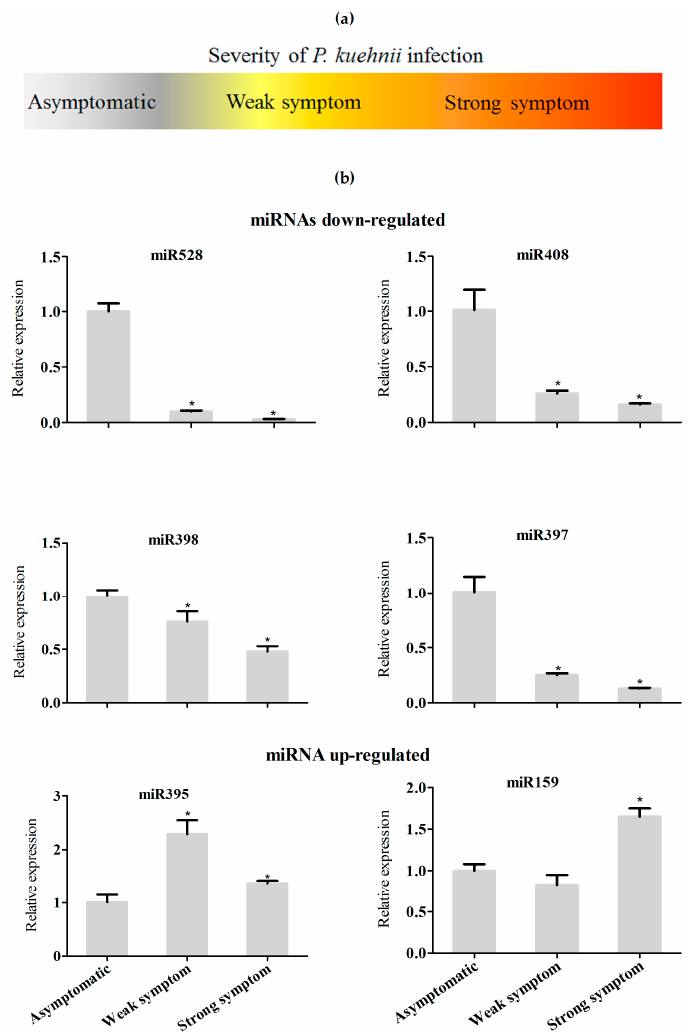
Figure 7. Expression analysis of selected miRNA in sugarcane plants infected with Puccinia kuehnii . ( a ) Severity of the disease symptoms in P. kuehnii infected sugarcane plants used analyzed; ( b ) miRNAs levels in asymptomatic plants and in P. kuehnii -infected plants, assayed by real-time PCR. Statistics were calculated between control and inoculated treatments. The error bars represent the standard deviation between three technical replicates. * represents significant differences in expression between the control and infected samples ( p -value <